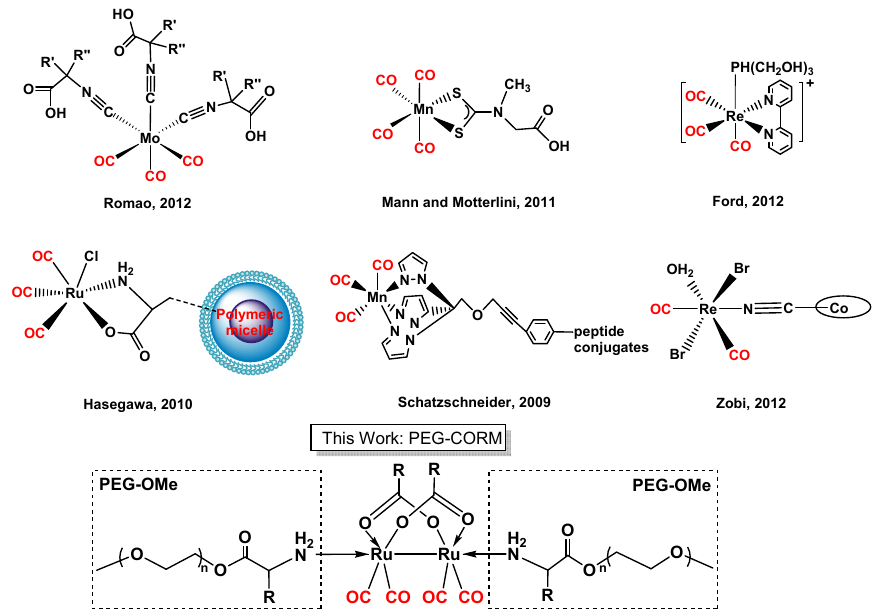
Scheme 1. Selected Water-soluble